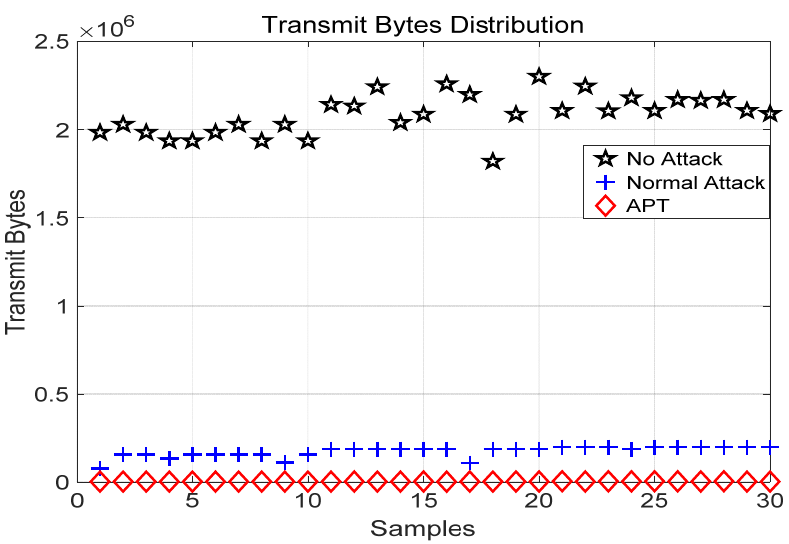
Figure 10. The average transferred bytes difference.